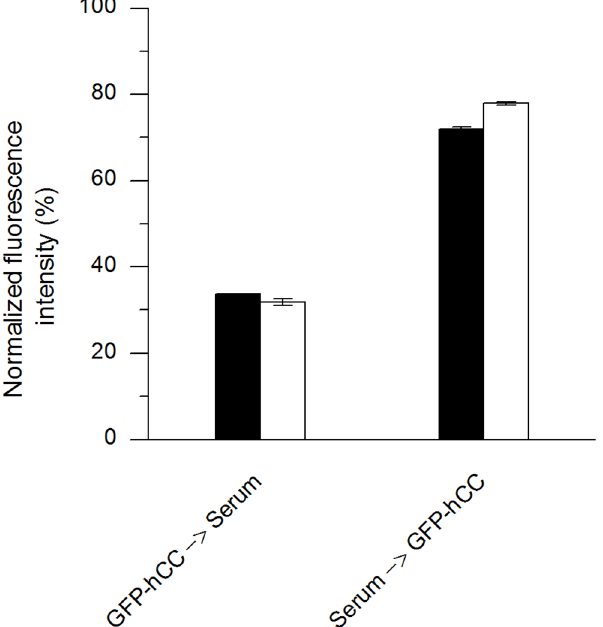
Fig 10. Replacement assay in both directions using reference material. The assays were carried out three times. The mean intensity, resulting from assay repetition, was normalised to the positive control and shown as a percentage for the different time points. GFP-hCC → Serum: GFP-hCC replaced with non-diluted reference material, Serum → GFP-hCC: non-diluted reference material replaced with